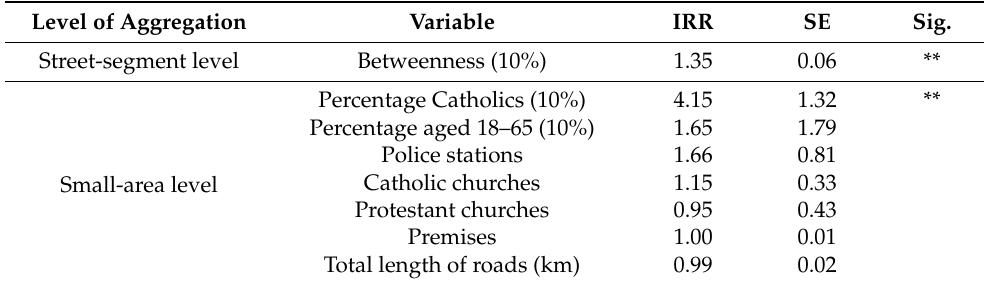
Table A2. Estimates from an OLRE Poisson regression of the location of violent dissident Republican incidents without street segment ‘totals’ variables.